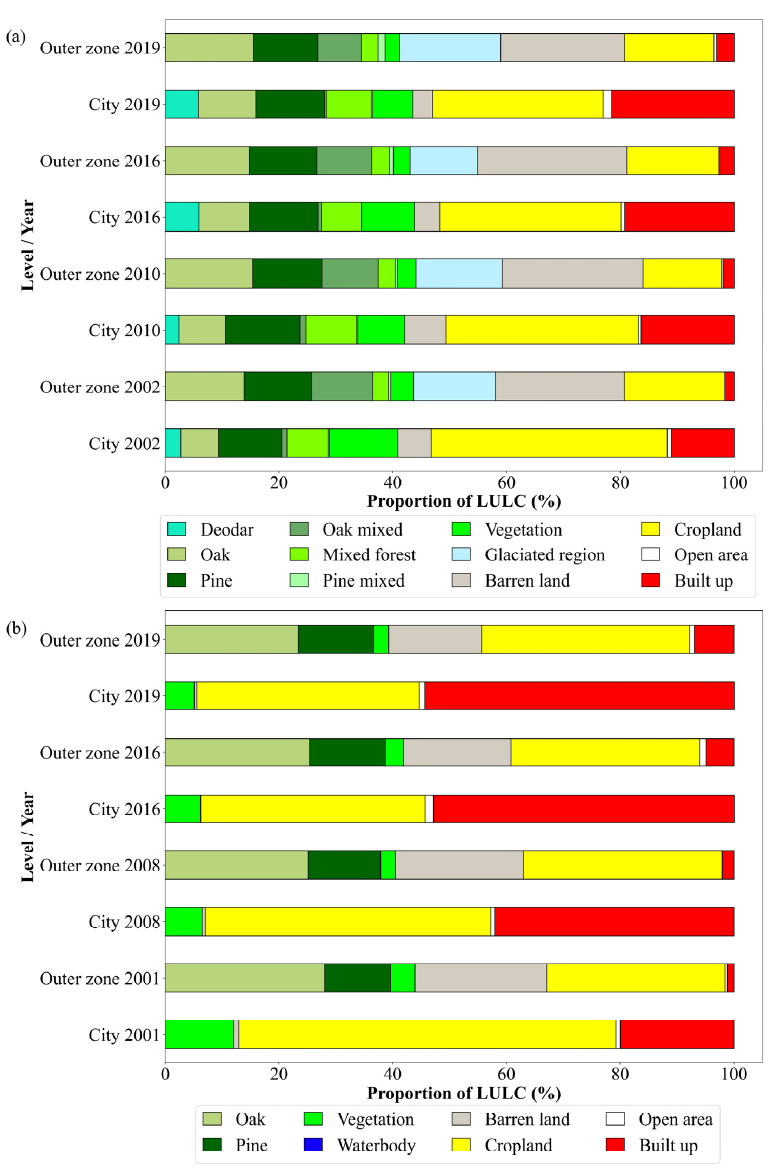
Figure 2. Variations in the proportion of LULC among the reference years of study period at city and outer zone level in ( a ) Dharamsala and ( b ) Pithoragarh. outer zone level in ( a ) Dharamsala and ( b )